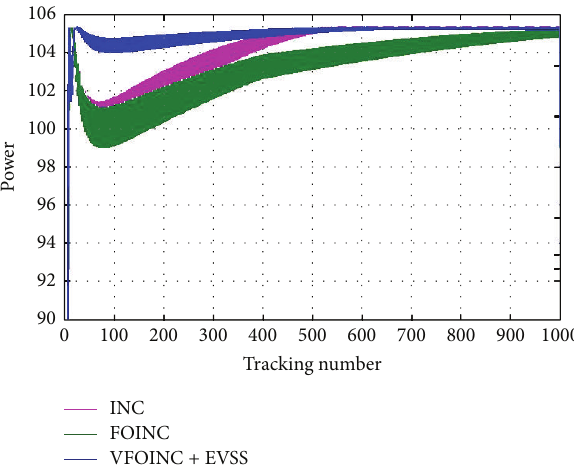
Figure 8: Curve test with specific temperature and irradiance.